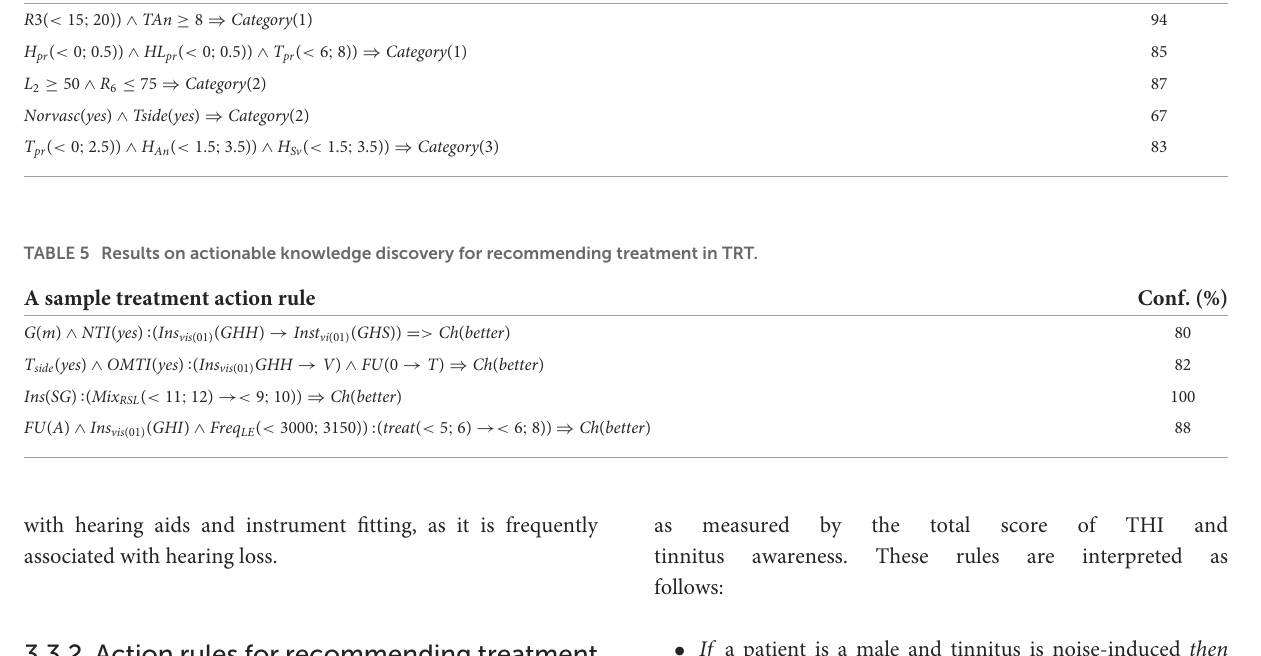
TABLE 4 Examples of discovered decision rules for the category of a hearing problem determined based on the interview and audiometric values. Sample association rule for diagnostics in TRT